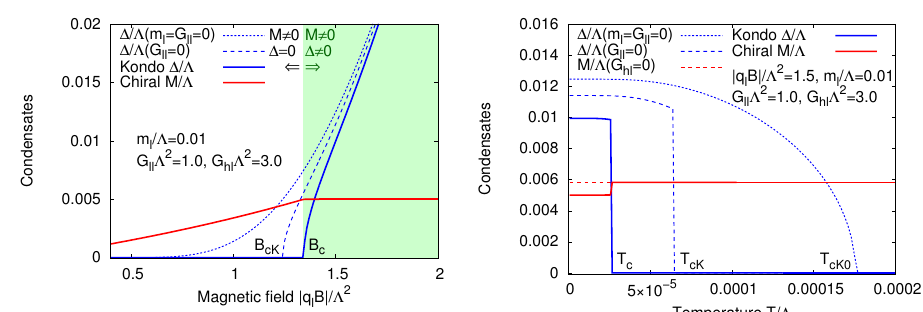
Figure 1. Magnitudes of the chiral and Kondo condensates at zero temperature (left) and at finite temperature (right) [6]. The solid lines show the full results with nonzero G hl and G ll , while the dotted and dashed lines show the results with the competition turned o ff with either G ll = 0 or G ll = 0.